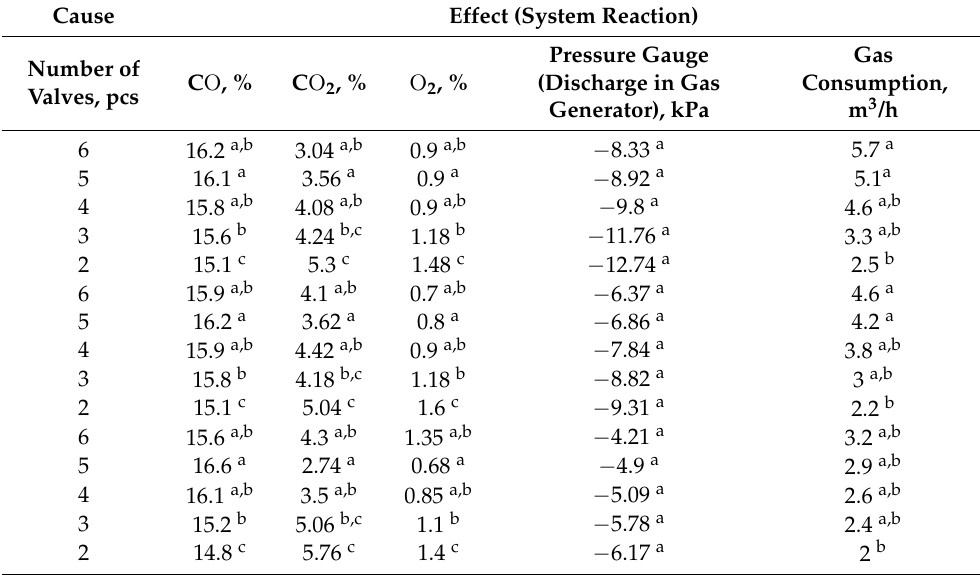
Table 2. Change in the chemical composition of generator gas in the gas generator depending on the number of electromagnetic valves